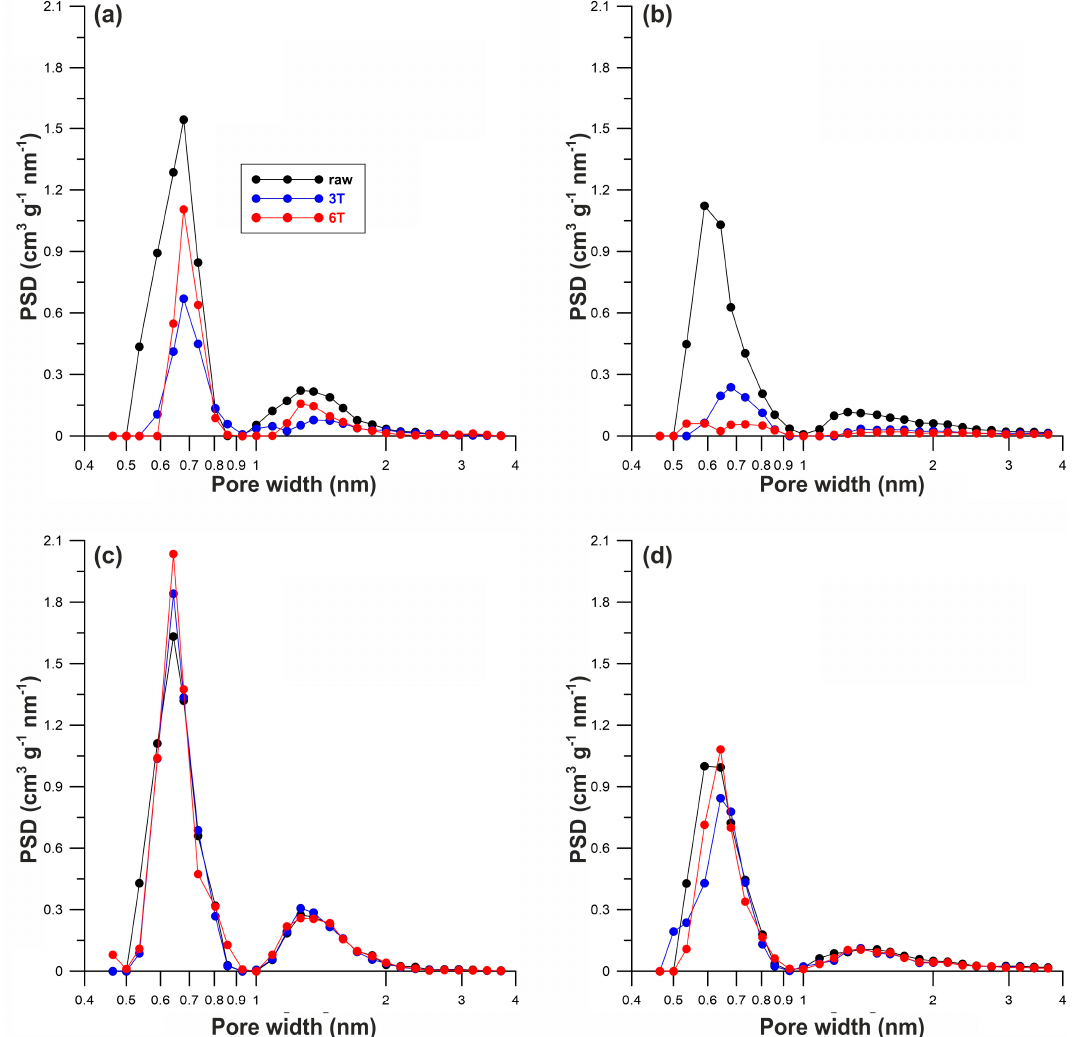
Figure 2. Pore size distribution calculated from the adsorption branch using the Nguyen and Do (ND) method [26,27] for ( a ) Norit_1, ( b ) Norit_2, ( c ) Norit_1_ox, and ( d ) Norit_2_ox.